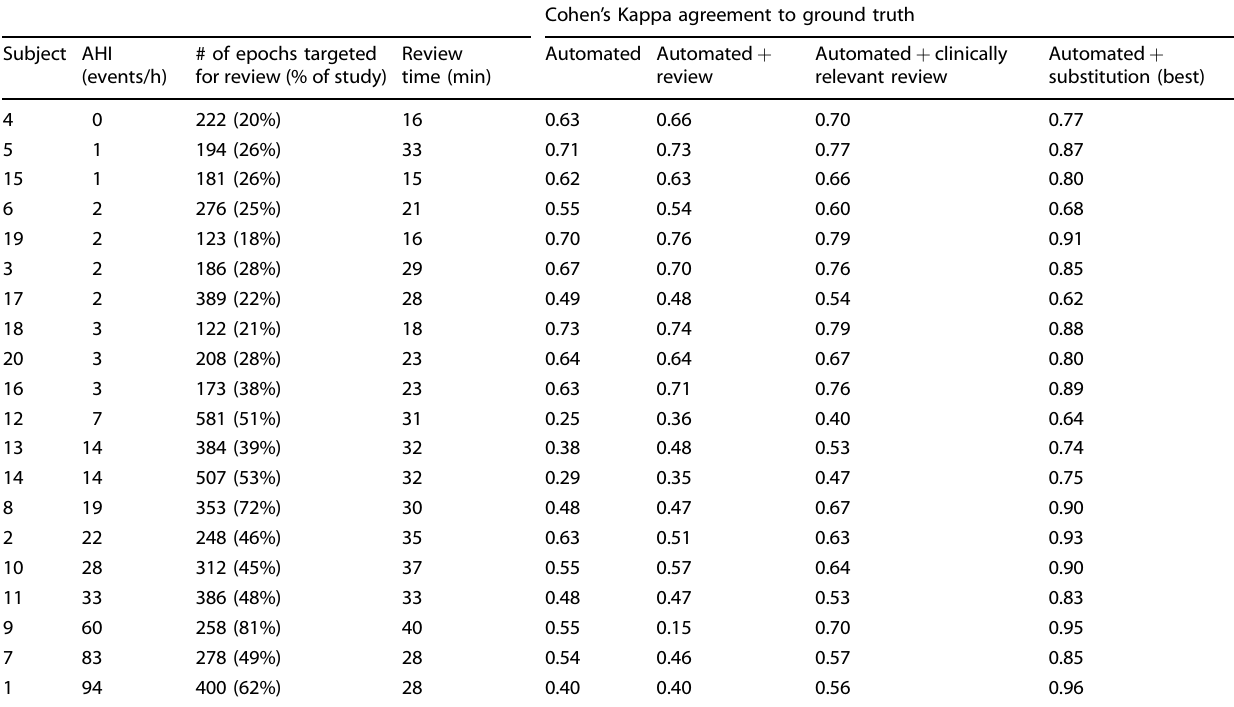
Table 1. Subject data (e.g. AHI), per-subject accuracies, epochs reviewed, scoring time and accuracies. Cohen ’ s Kappa agreement to ground